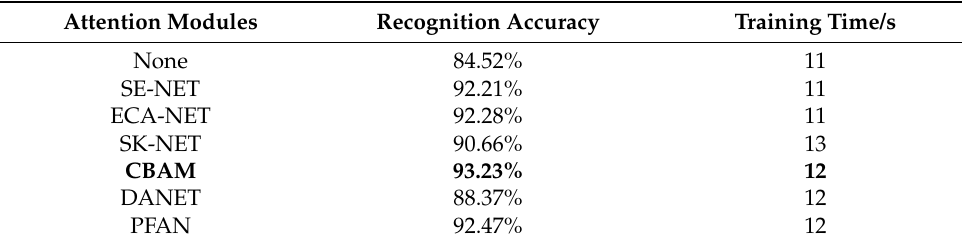
Table 1. Performance comparison of different attention modules